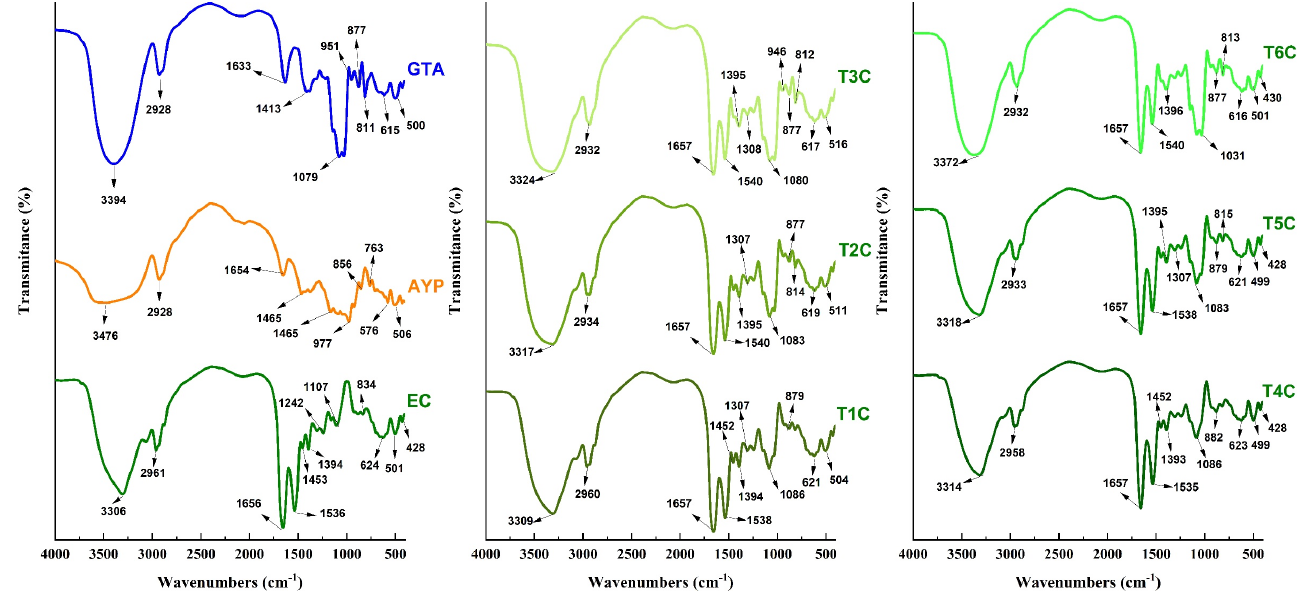
Figure 7. Infrared spectra in tara gum (GTA), native potato starch of the yanapalta variety (AYP), erythrocytes (EC) and encapsulated at 120 °C (T1C, T2C, and T3C) and 140 °C (T4C, T5C, and T6C).